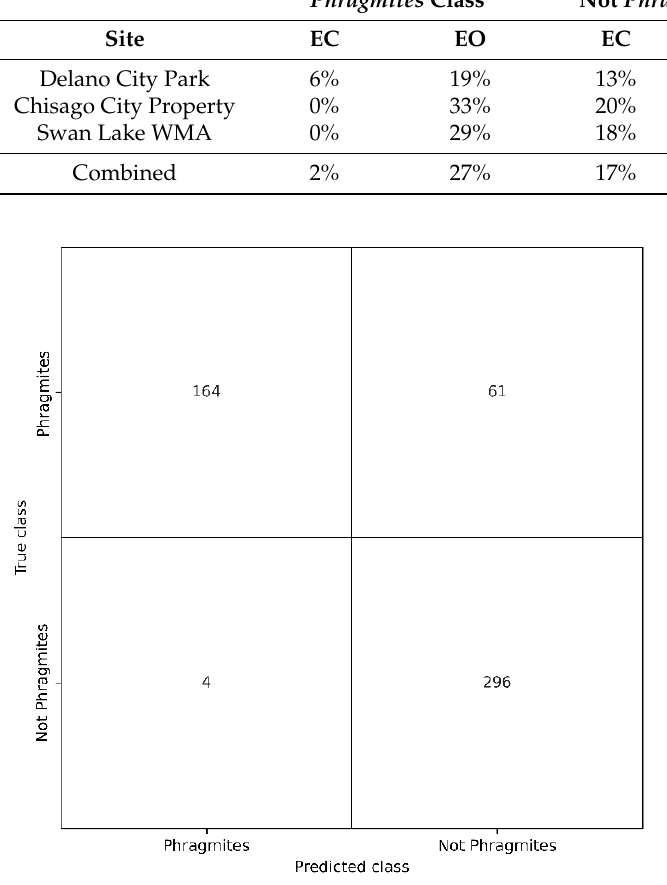
Figure 8. Combined confusion matrix for the three validation sites classified using an artificial neural network without the post-ML OBIA rule set. A classification accuracy of 88% was achieved. The Phragmites class had a producer’s accuracy of 73% and a user’s accuracy of 98%. The Not Phragmites class had a producer’s accuracy of 99%, while achieving a user’s accuracy of